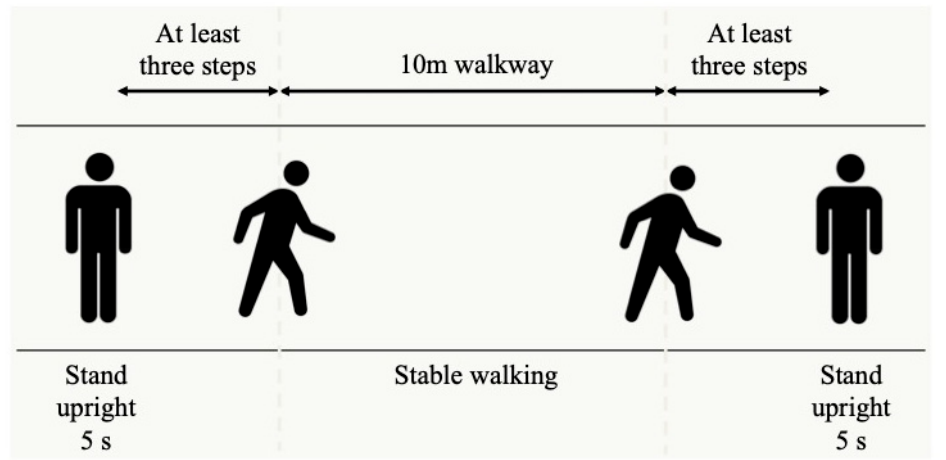
Figure 1. Measurement set-up.